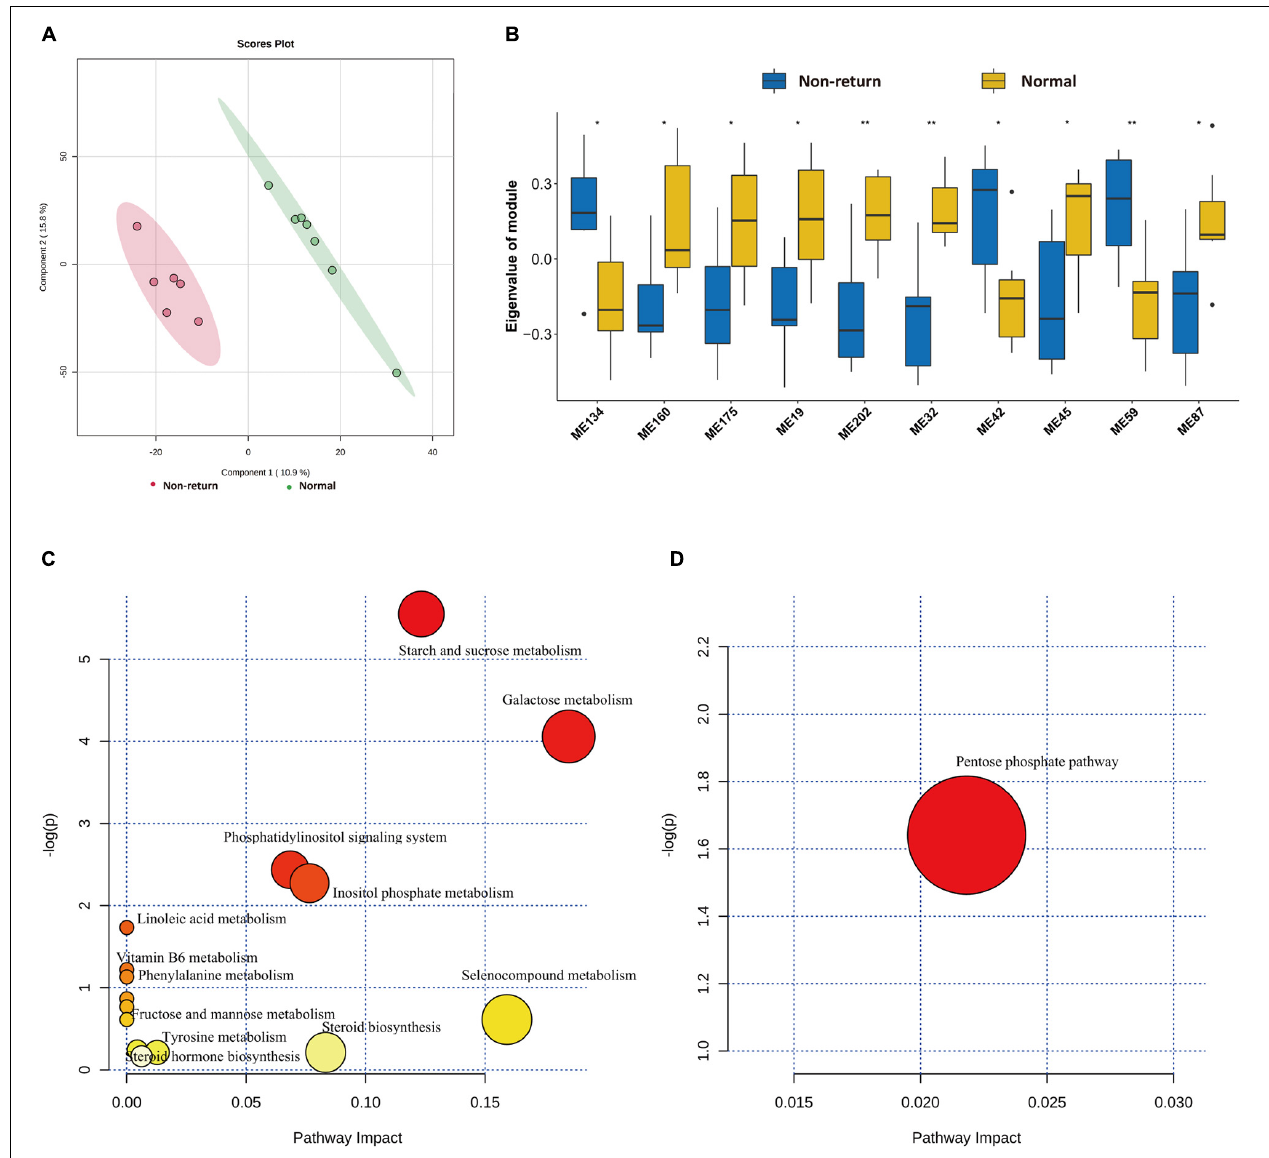
FIGURE 6 | Identification of differential metabolic profiles between normal return and non-return Sows. (A) PLS-DA diagram of serum metabolic profiles shows significant differences of serum metabolites profiles between normal return and non-return sows. (B) Box plots indicate 10 co-abundance clusters of serum metabolites between normal return and non-return sows. t -test was used for difference analysis, * p < 0.05, ** p < 0.01. (C) The KEGG pathway enriched by serum metabolite features having higher abundance in serum of normal sows. (D) The KEGG pathways enriched by serum metabolite features having higher abundance in serum of non-return sows. The x -axis and the size of dots indicate the KEGG pathway impact of differential serum metabolite features, and the y -axis shows the –log 10 of significant p -value in metabolite enrichment analysis. The size and color of dots represent the value of the KEGG pathway impact.